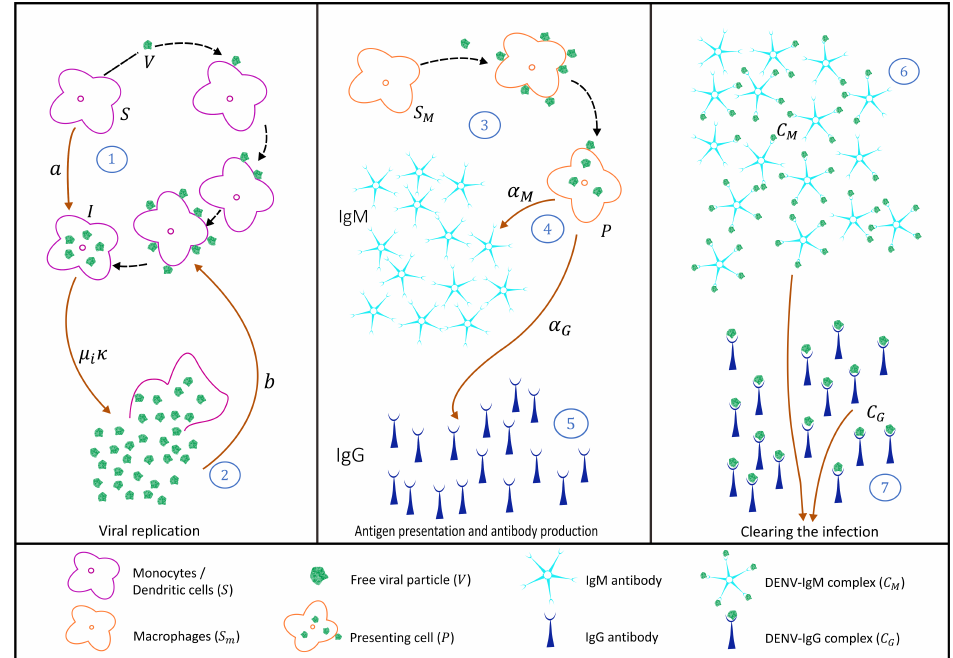
Figure 1. Schematic in-host dengue immunological responses mediated by antibodies: primary infection. Three blocks are used to describe 7 steps during the infection, from viral replication up to infection